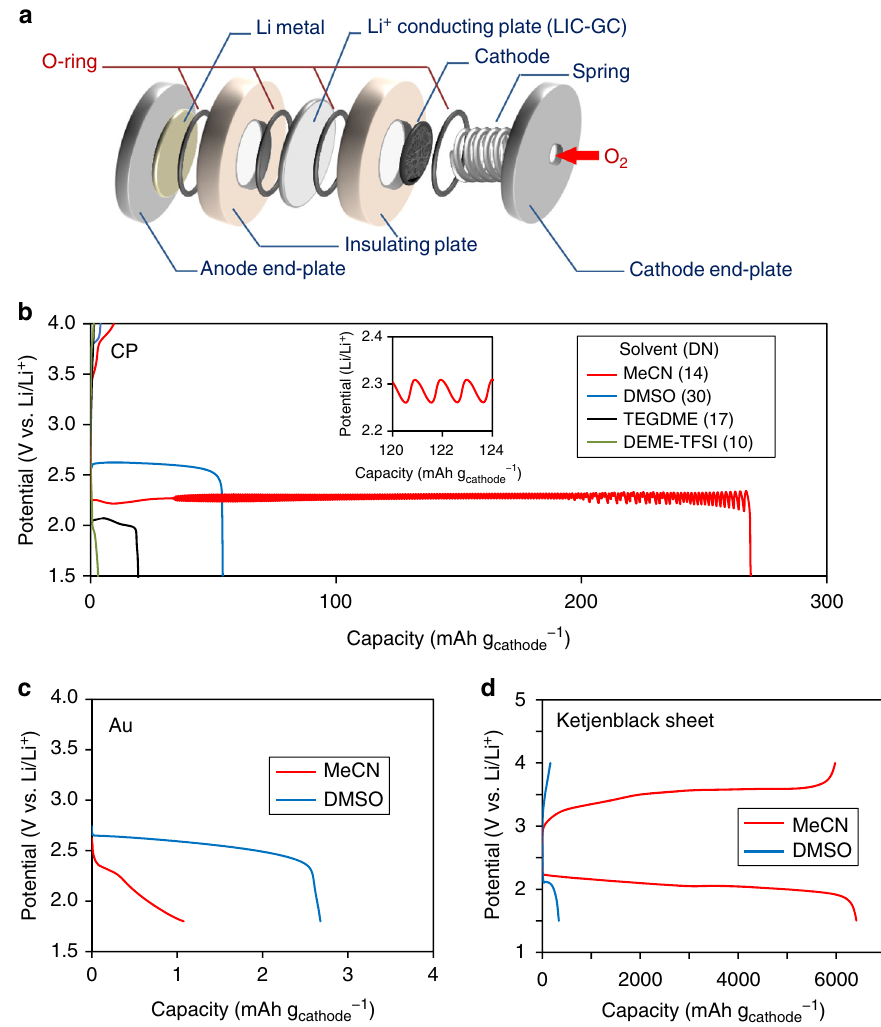
Fig. 1 Discharge and charge curves of Li-O 2 cells employing various solvents with 0.5 M LiTFSI electrolytes. a The schematic illustration of an electrochemical cell for a Li-O 2 battery. b – d The discharge and charge curves of the Li-O 2 cells employing carbon paper (CP) ( b ), Au-mesh ( c ), and Ketjenblack sheet ( d ) as cathodes. The applied current densities were 0.2 mA cm − 2 ( b ), 0.02 mA cm − 2 ( c ), 1.25 mA cm − 2 ( d , discharge), and 0.25 mA cm − 2 ( d charge). b The inset shows the magni fi ed image of